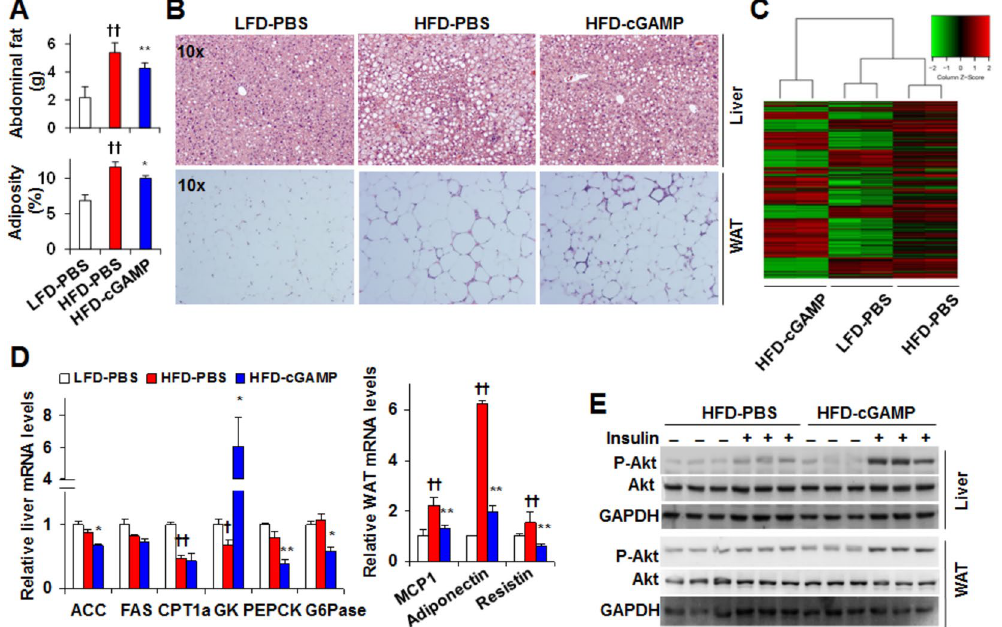
Figure 4. Treatment with cGAMP ameliorates diet-induced liver and adipose tissue metabolic dysregulation. ( A ) Abdominal fat mass and adiposity. ( B ) Liver (top) and adipose tissue (bottom) sections were stained with H&E. ( C ) Liver microarray heat map and sample clustering dendrogram of RNA expression. ( D ) Liver and adipose tissue mRNA levels were analyzed using real-time PCR. ( E ) Liver and adipose tissue insulin signaling. For A–E, male C57BL/6 J mice, at 5–6 weeks of age, were fed a high-fat diet (HFD) for 12 weeks and treated with cGAMP (intraperitoneally, 0.2 mg/kg/d, in PBS) or PBS for the last 4 weeks. Age- and gender-matched C57BL/6 J mice were fed a low-fat diet (LFD) and treated with PBS. After the feeding/treatment periods, mice were fasted for 4 hr prior to harvest. WAT, white adipose tissue. For E, prior to tissue harvest, mice were injected with or without insulin (1 U/kg) into the portal vein for 5 min. Tissue lysates were subjected to Western blot analyses. Cropped blots were displayed. Also, full-length blots were included in Supplemental Information (Figure S11). For bar graphs, data are means ± S.E. n = 6–10. * P < 0.05 and ** P < 0.01 HFD-cGAMP vs. HFD- PBS (in A) for the same gene (in D); † P < 0.05 and †† P < 0.01 HFD-PBS vs. LFD-PBS (in A) for the same gene (in